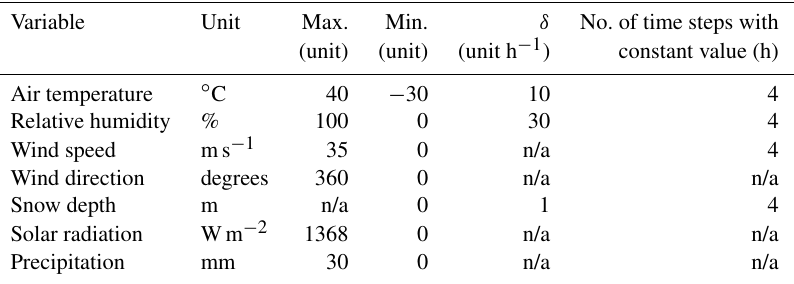
Table A3. Thresholds used to instigate quality control procedures of the weather data, with the maximum and minimum values, a maximum rate of change ( δ ), and the maximum number of time steps with a constant value. Outlier data were flagged or, where necessary, corrected and gap-filled. n/a represents not